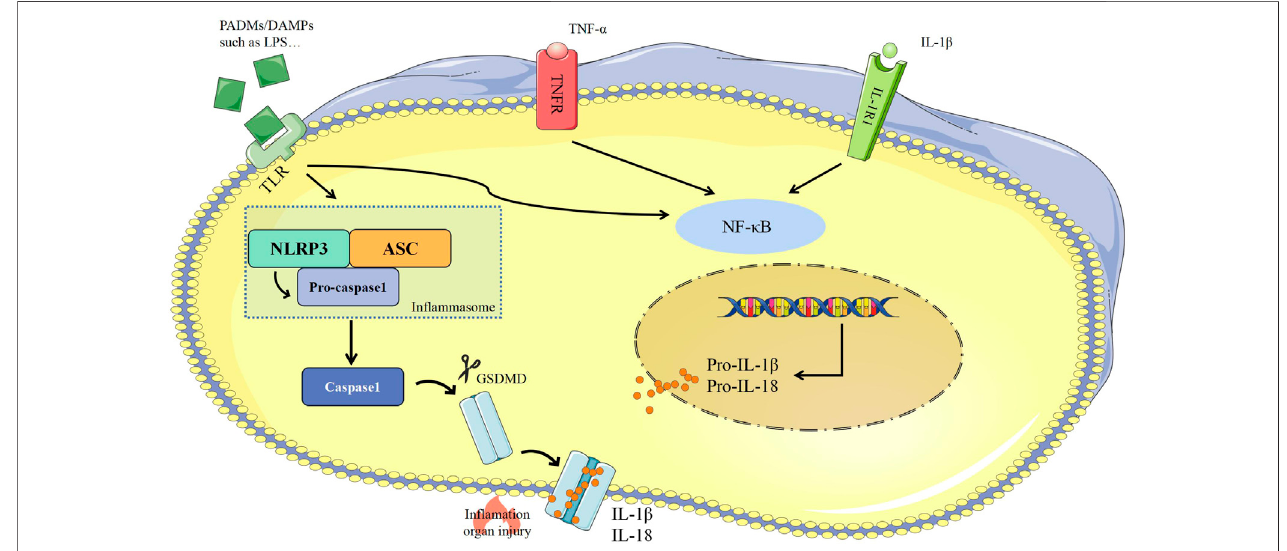
FIGURE 2 | Caspase 1-dependent pyroptosis. ASC, apoptosis-associated speck-like protein; Caspase-1, cysteine-aspartic proteases-1; DAMPs, damage- associated molecular patterns; GSDMD, gasdemin D; IL-1 β , interleukin-1 β ; IL-18, interleukin-18; IL-1R, interleukin-1 receptor; NLRP3, NOD-, LRR-, and pyrin domain- containing protein-3; LPS, lipopolysaccharide; NF- κ B, nuclear factor kappa-B; PAMPs, pathogen-associated molecular patterns; TLR, Toll like receptor; TNF- α , tumor necrosis factor- α ; TNFR1, tumor necrosis factor receptor.